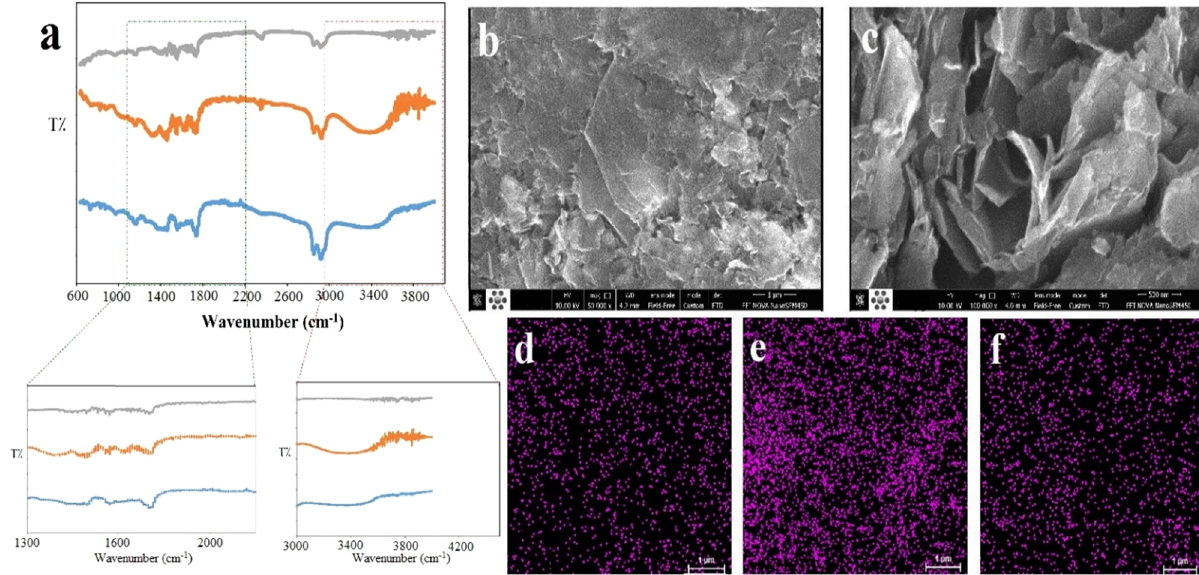
Figure 2: ( a ) ATR - FTIR spectra of bare, GON - modi fi ed, and rGON - modi fi ed graphite electrodes, ( b ) SEM image of unmodi fi ed graphite electrode, ( c ) SEM image of rGON - modi fi ed graphite electrode, ( d – f ) EDS mapping analysis of oxygen element on the bare, GON - modi fi ed, and rGON - modi fi ed graphite